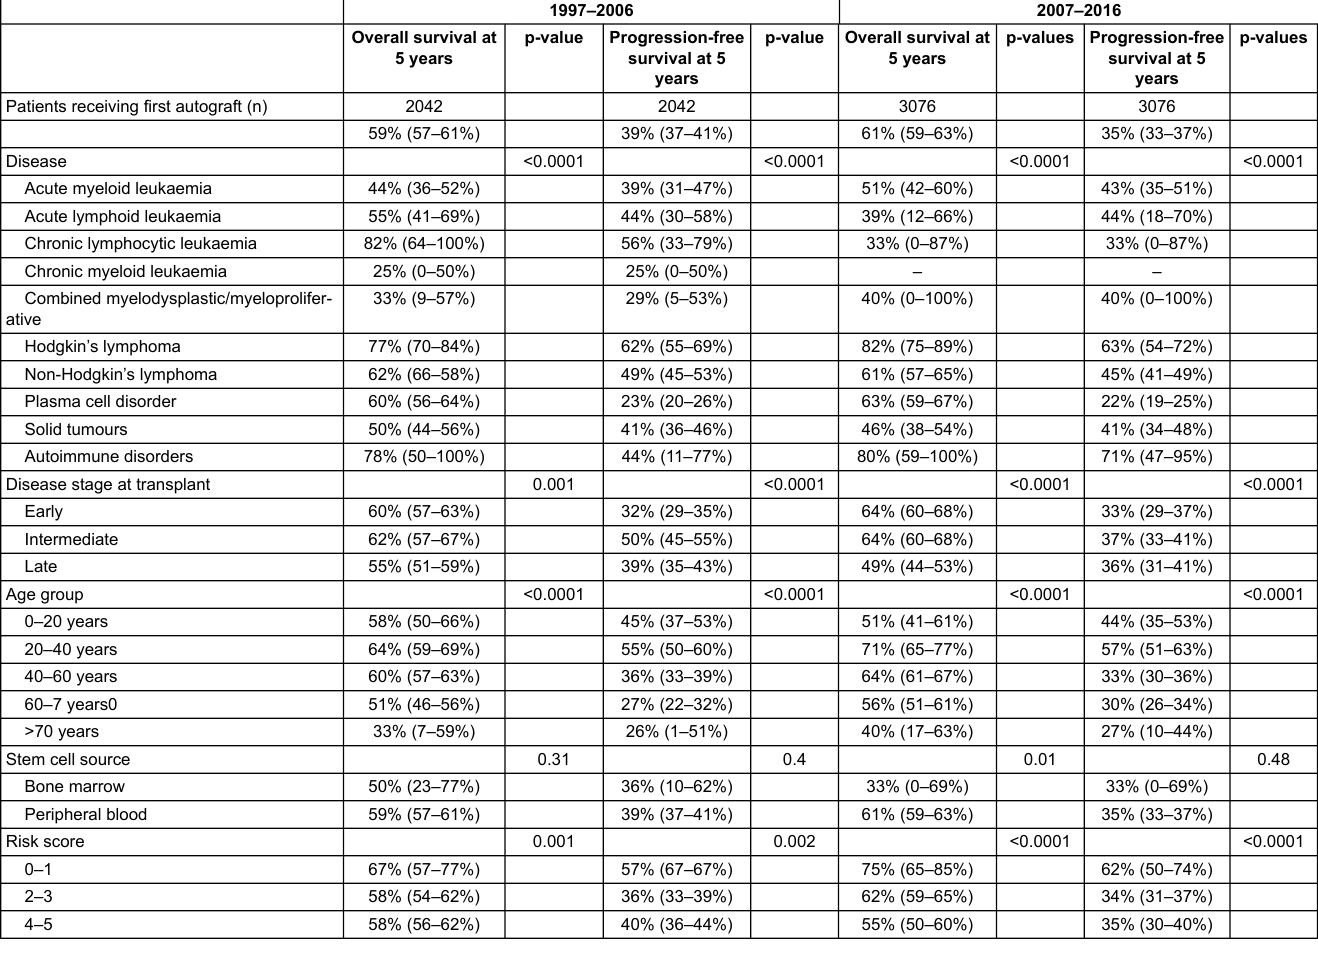
Table 2b: Univariate analysis of overall and progression-free survival for autologous haematopoietic cell transplants by decade for the years